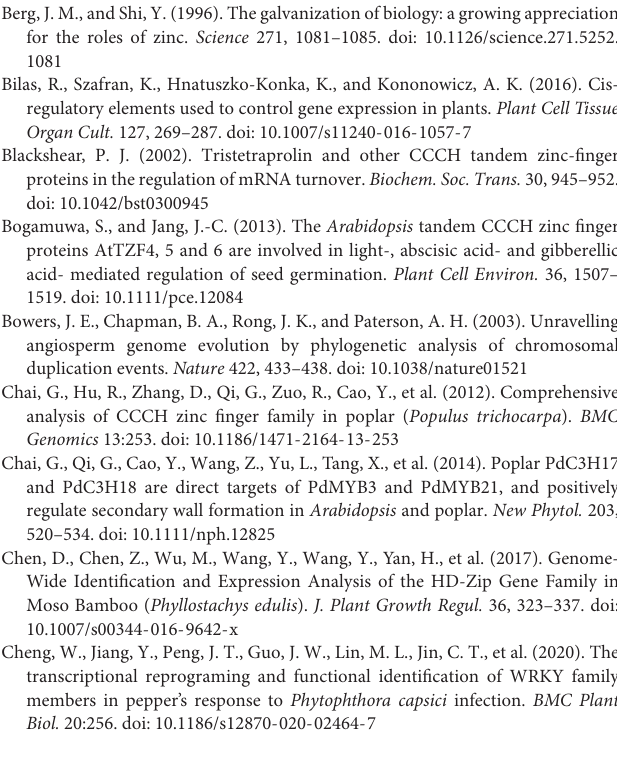
Supplementary Table 5 | K a / K s value for duplicate CCCH genes between moso bamboo and rice. Supplementary Table 6 | K a / K s value for duplicate CCCH genes between moso bamboo and maize. Supplementary Table 7 | Kinds and numbers of known stress-related elements in the upstream regions of CCCH genes in moso bamboo. Supplementary Table 8 | The 12 gene primer